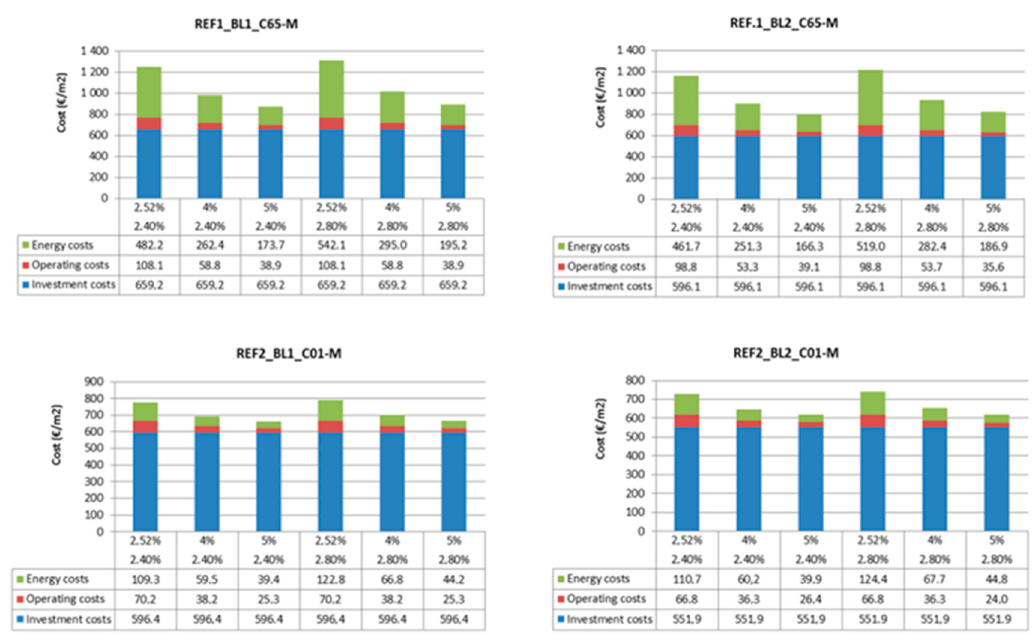
Figure 6. Sensitivity analysis for Reference building 2.